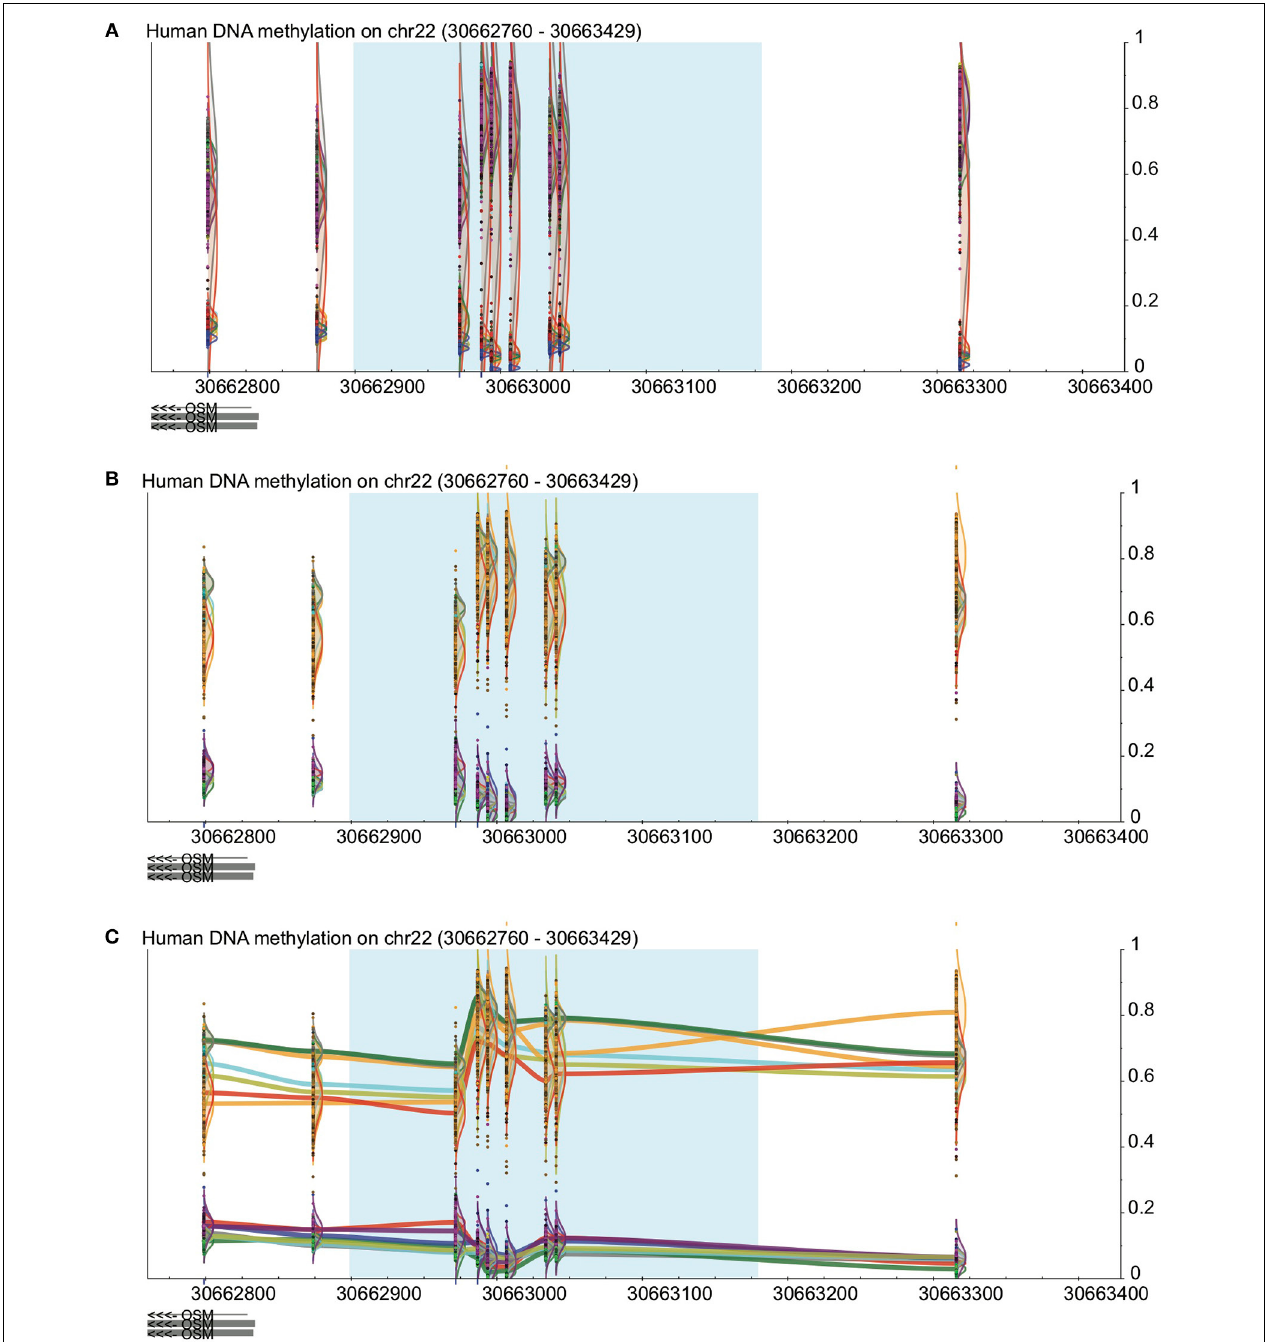
FIGURE 2 | Visualization in DaVIE across projects. See Figure 1 for key. (A) In a total of over 500 samples in 12 different tissues, distinct groups are observed but separation is not achieved when the samples are colored by